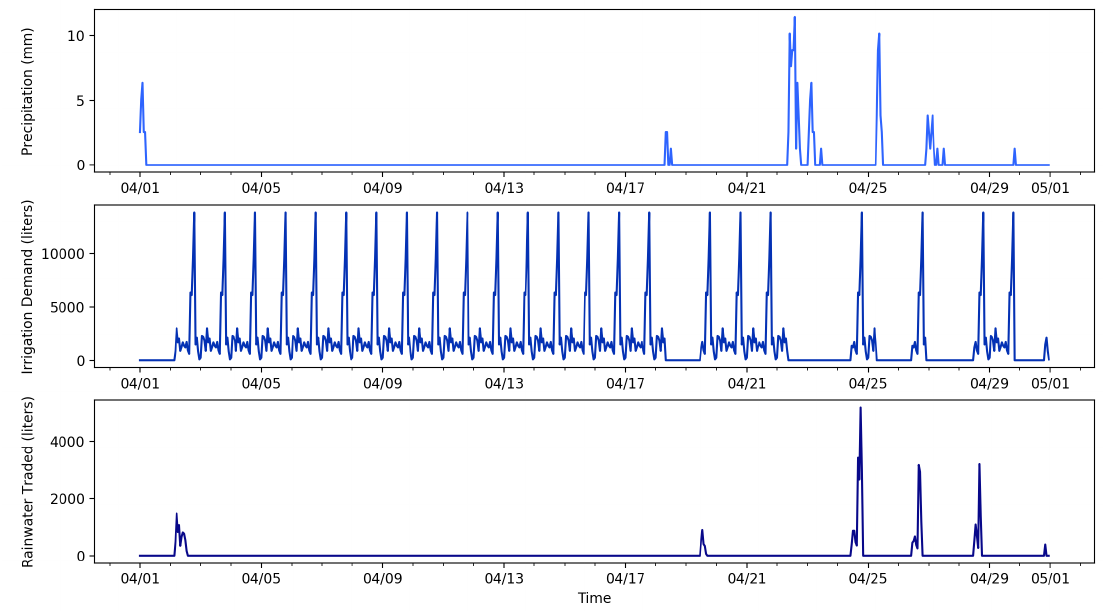
Figure 5. Precipitation, irrigation demand volume, and traded rainwater volume for Scenario 20% − 1 P